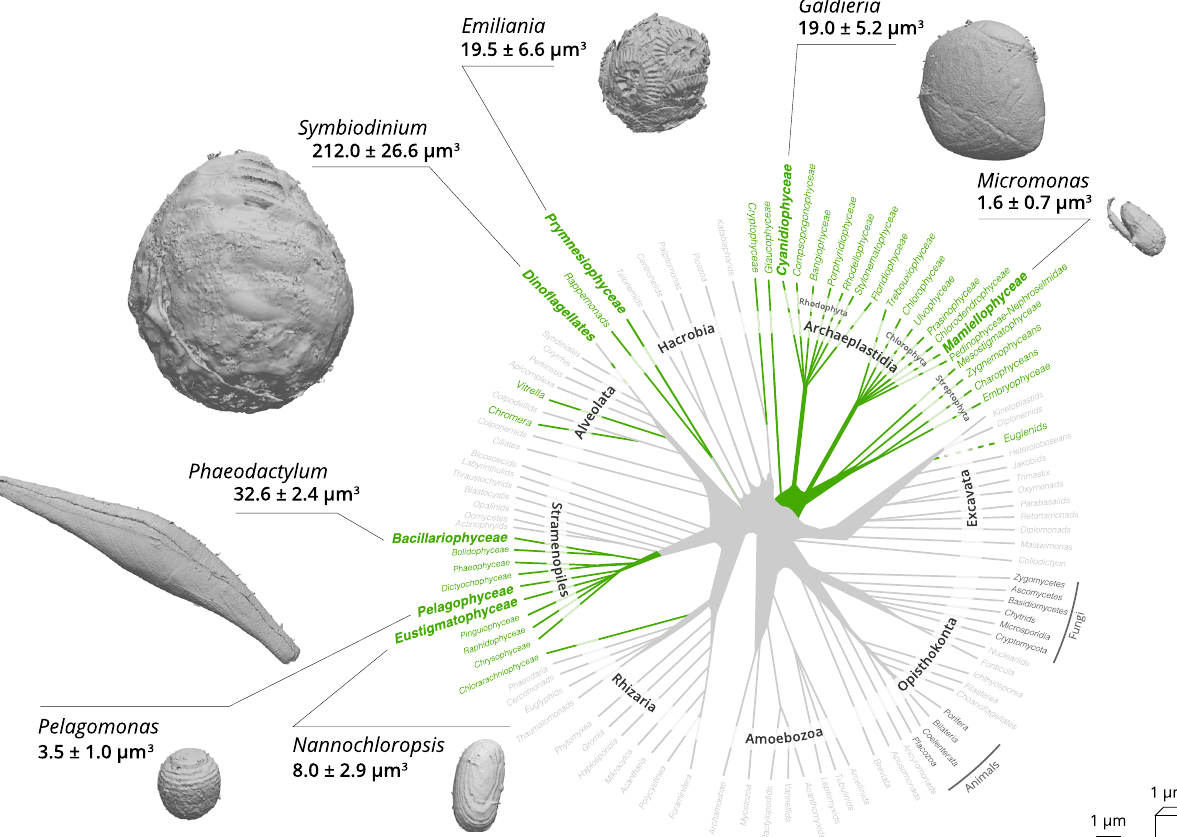
Fig. 1 Cellular volume and external features of selected phytoplankton cells revealed by FIB-SEM imaging. Green branches of the phylogenetic tree of eukaryotes represent photosynthetic lineages (adapted from ref. 91 ). A 3D scan view of cell morphology of selected phytoplankton members (Mammiellophyceae ( Micromonas RCC 827 ), Prymnesiophyceae ( Emiliania RCC 909 ), Bacillariophyceae ( Phaeodactylum Pt1 8.6 ), Pelagophyceae ( Pelagomonas RCC 100 ), Dinophyceae ( Symbiodinium RCC 4014 clade A), Cyanidiophyceae ( Galdieria SAG21.92) and Eustigmatophyceae ( Nannochloropsis CCMP526) is shown with a linear scale bar of 1 µ m and a voxel scale of 1 µ m 3 . Speci fi c cellular features (cell walls, the fl agellum in Micromonas , the raphe in Phaeodactylum , the coccosphere in Emiliania ) are visible. For every species, three cells were reconstructed and morphometrically analysed. Data represent cell volumes ± s.d. for every